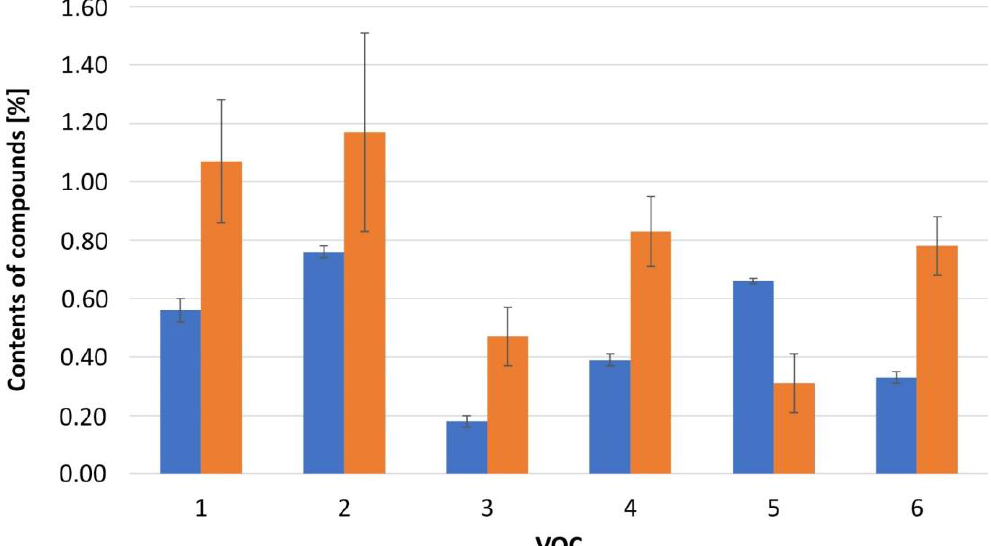
Figure 3. Effect of the place where the sample was collected on the percentage of VOC: Compounds: 1 — selina-5,11 -diene ( 41 ) , 2 —δ -elemene ( 22 ), 3 —β -elemene ( 29 ), 4 —γ -maaliene ( 38 ), 5 —β -pinene ( 12 ), 6 —α -maaliene ( 39 ). Collected place: liverworts growing on soil liverworts growing on a rotten tree under the forest litter.